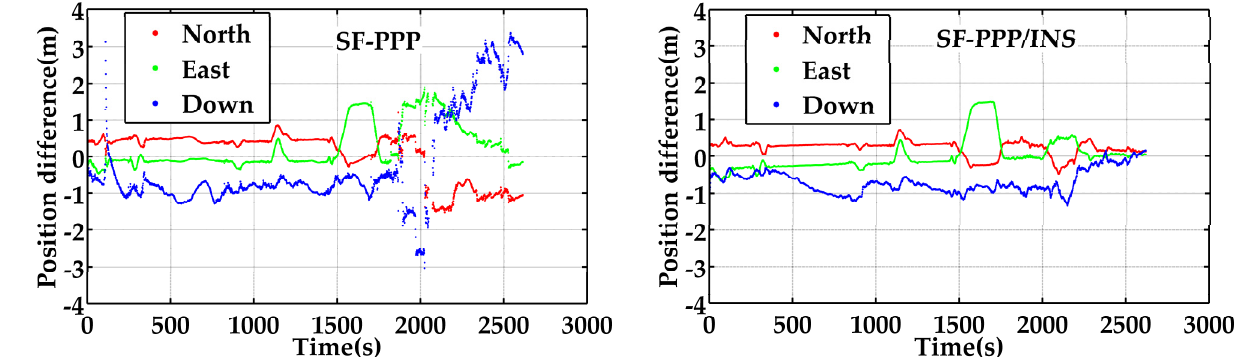
Figure 4. Position differences provided by G + B SF-PPP ( left ) and G + B SF-PPP/INS tight integration ( right ) in the three directions, in terms of the reference solution provided by RTK/INS tight integration (the start time is 195,453 s).